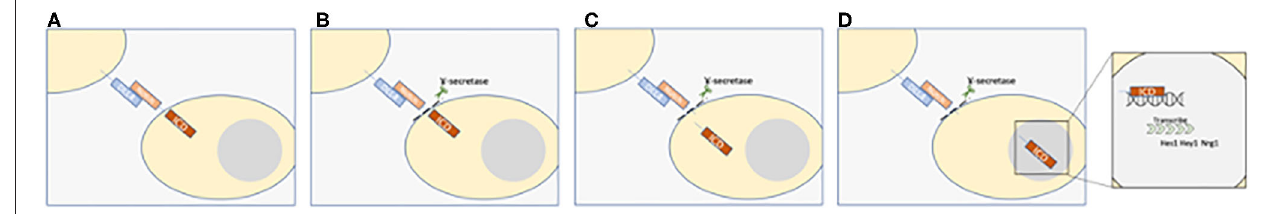
FIGURE 1 | Notch signal activation. (A) Notch Receptor and DLL4 ligand bind together. (B) γ -secretase cleaves the Intracellular domain (ICD) from the extracellular domain. (C,D) The ICD is released and travels into the nuclease. ( D inset) The ICD binds onto the DNA as a transcription factor to transcribe downstream Notch genes such as Hes1, Hey1, and